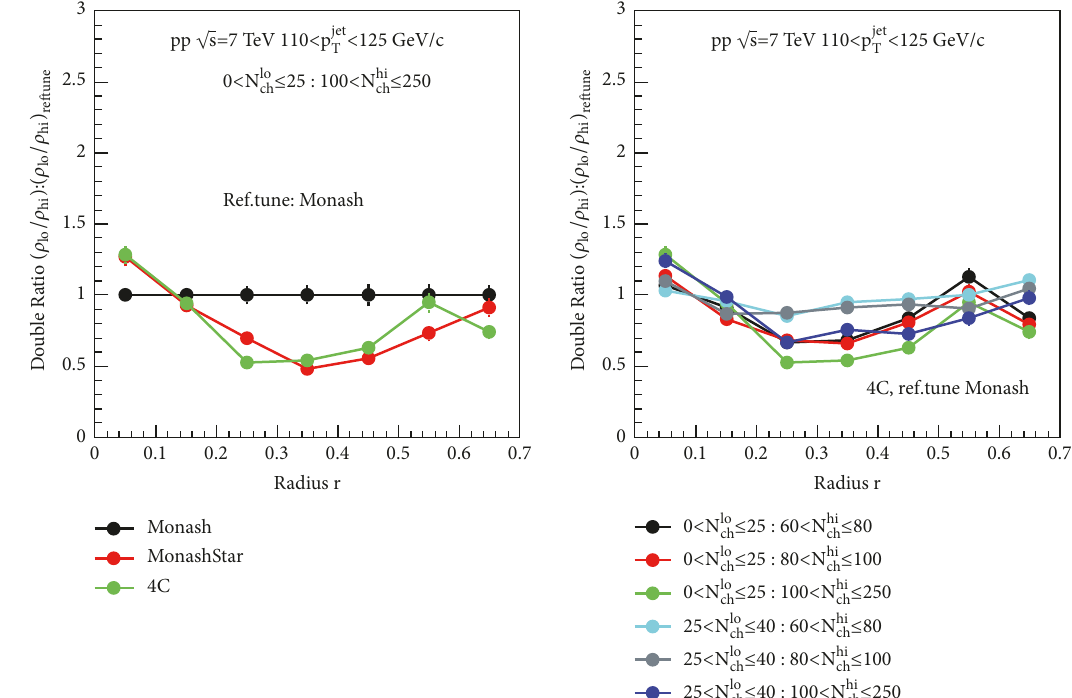
Figure 10: Left: the double ratio with Monash as the reference tune for the same multiplicity classes. Right: the double ratio shown for different selections of high- and low-multiplicity classes (see text in